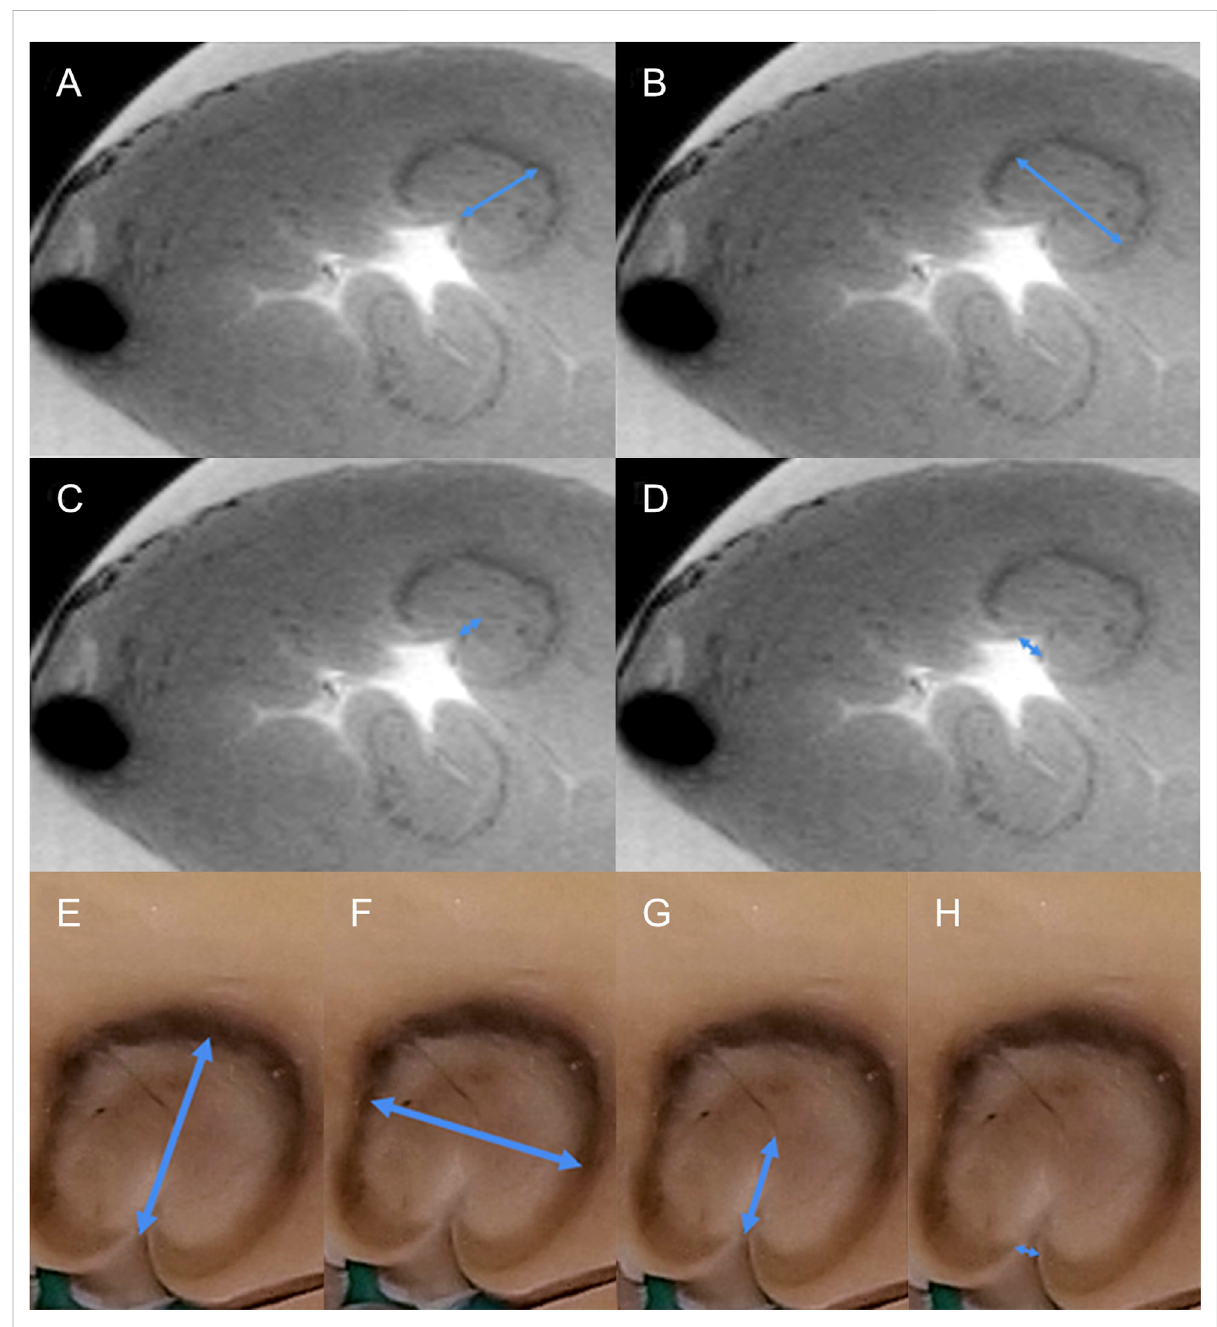
FIGURE 2 Example of measurement of the different dimensions of the radiofrequency lesion. (A – D) , measurement from MRI data, transverse section of theleftventricle.Twolesionsare visible, theupperoneismeasured(bluearrows,A= depth,B=width, C=depth atthemaximumdiameter, andD= lesion surface diameter ( “ estuary). (E – H) , measurement from pathological samples, detail of the lesion, the same measurement as for MRI [blue arrows, E = depth, F = width, G = depth at the maximum diameter, and H = lesion surface diameter ( “ estuary ”